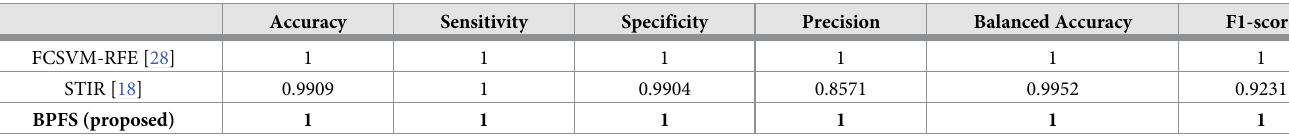
Table 5. Classification effectiveness analysis on the LUSC cancer